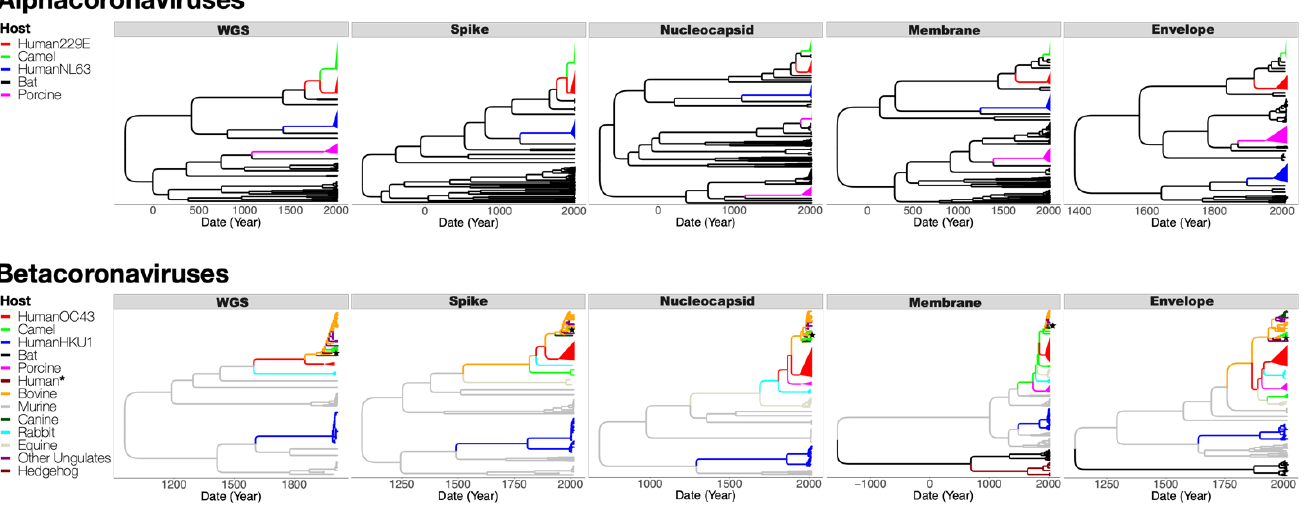
Figure 2. Maximum clade credibility (MCC) trees inferred from dataset D5 for full genomes (WGS), and the spike, nucleocapsid, membrane, and envelope ORFs, with the branches color-coded by the inferred coronavirus host. The upper panel shows MCC trees from alphacoronaviruses while the lower panel shows MCC trees from betacoronaviruses. Human, camel, and porcine coronavirus clades have been collapsed to increase readability. Human * is a lone human CoV (FJ415324) that clusters with ungulate and canine CoVs. Individual and more detailed MCC trees can be found in File S2. Table 1. The estimated zoonotic origins of the four species of human seasonal coronaviruses inferred from BEAST Markov Jumps (MJs) for whole genomes and the envelope, membrane, nucleocapsid, and spike ORFs. For 229E and OC43, we included the percentage of MJs of the presumptive ancestors, other potential ancestors with a percentage higher than the presumptive ancestor, or CoVs whose cumulative percentage of MJs were ≥